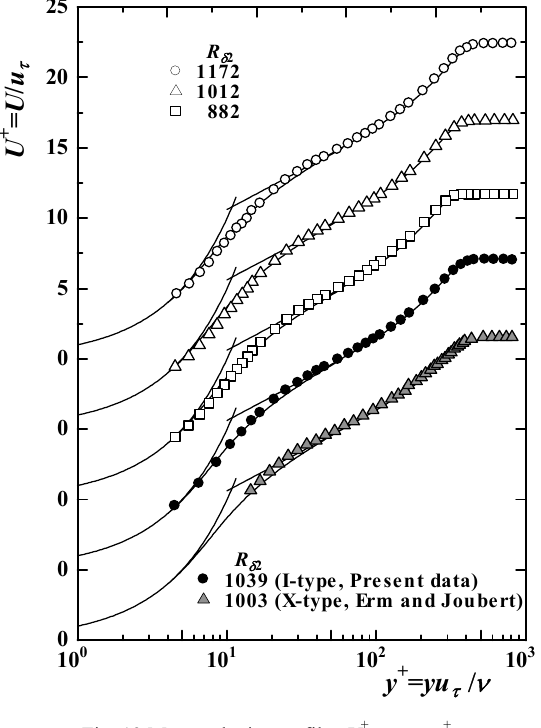
Fig. 13 Mean velocity profiles U + versus y + The solid lines are the calculated velocity profiles of Eq. (4) in the wall and